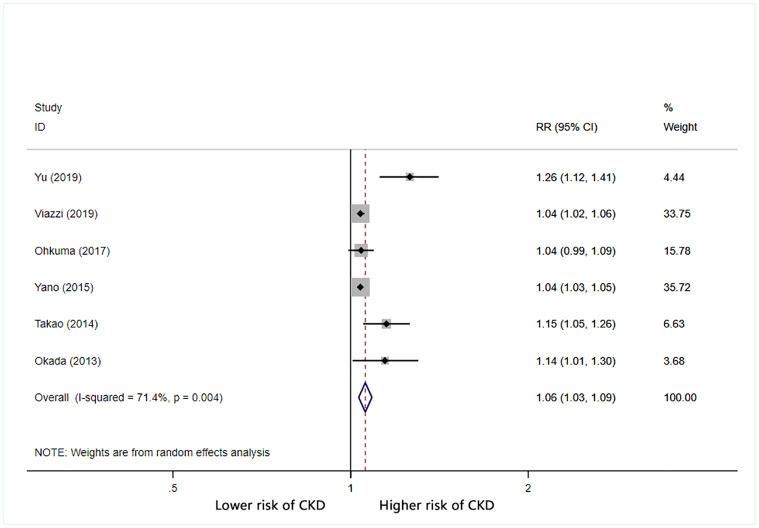
Forest plot of relationship between 1% increment in CV-SBP and risk of CKD.Boxes represent the Relative risk (RR) and lines represent the 95% Confidence Intervals (CIs) for individual studies. The area of each square is proportional to study weight. The diamonds and their width represent the pooled RRs and the 95% CIs, respectively.